Question: Which visualization type does this figure use?
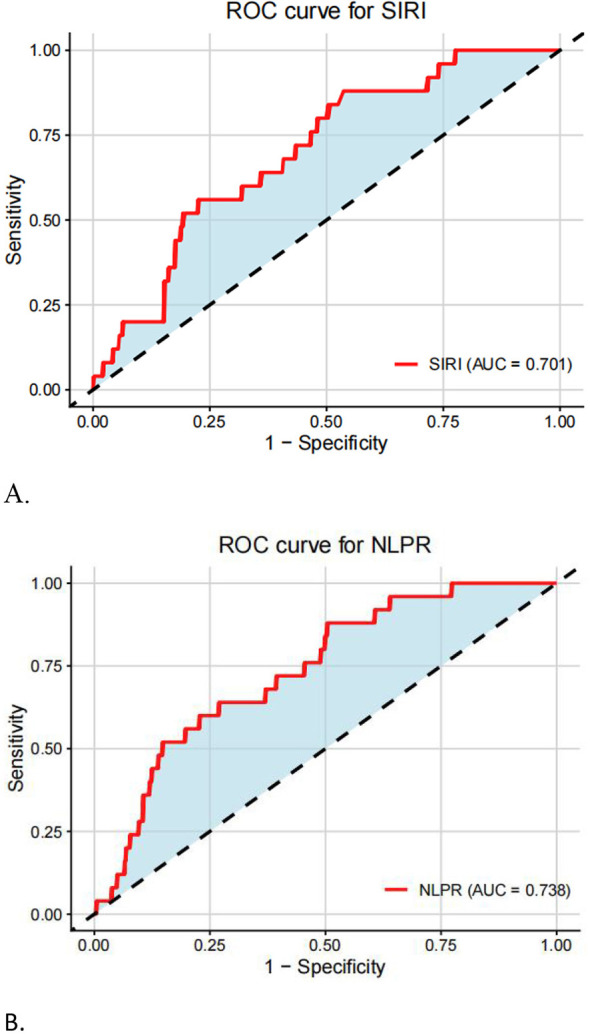
Answer: line